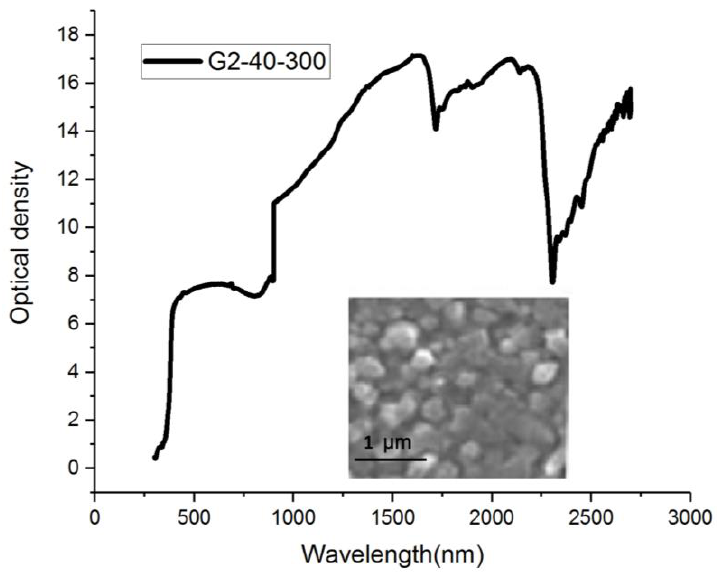
Figure 5. Proportions of individual elements of different CuIn x Ga (1-x) Se 2 (CIGS) films in the wavelength distribution of the optical spectrum (G2-40-300).